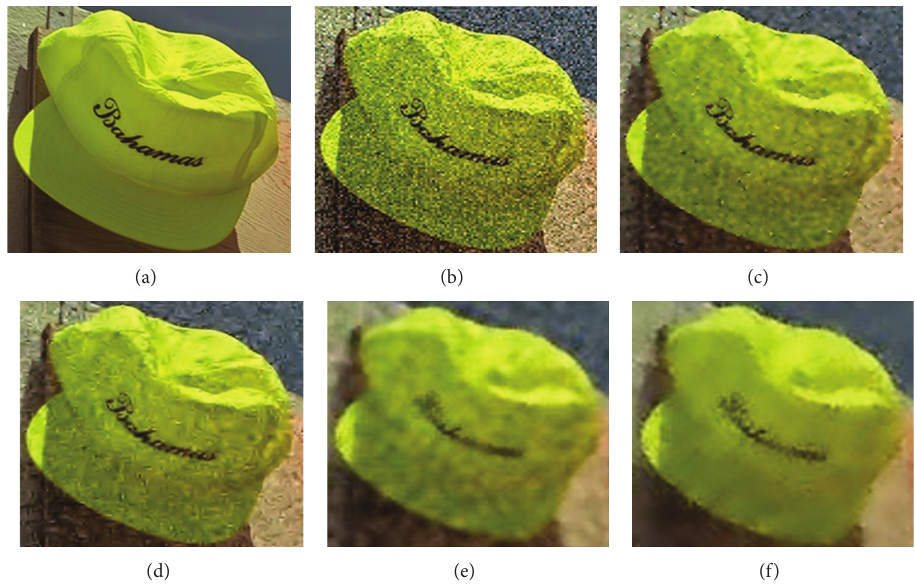
Figure 9: Denoising results of number 3 image in Kodak dataset with noise 𝜎 𝑛 = 30 : (a) original image; (b) noise image; and (c)–(f) images denoised by Wiener, JDD, JBF, and the proposed method, respectively.